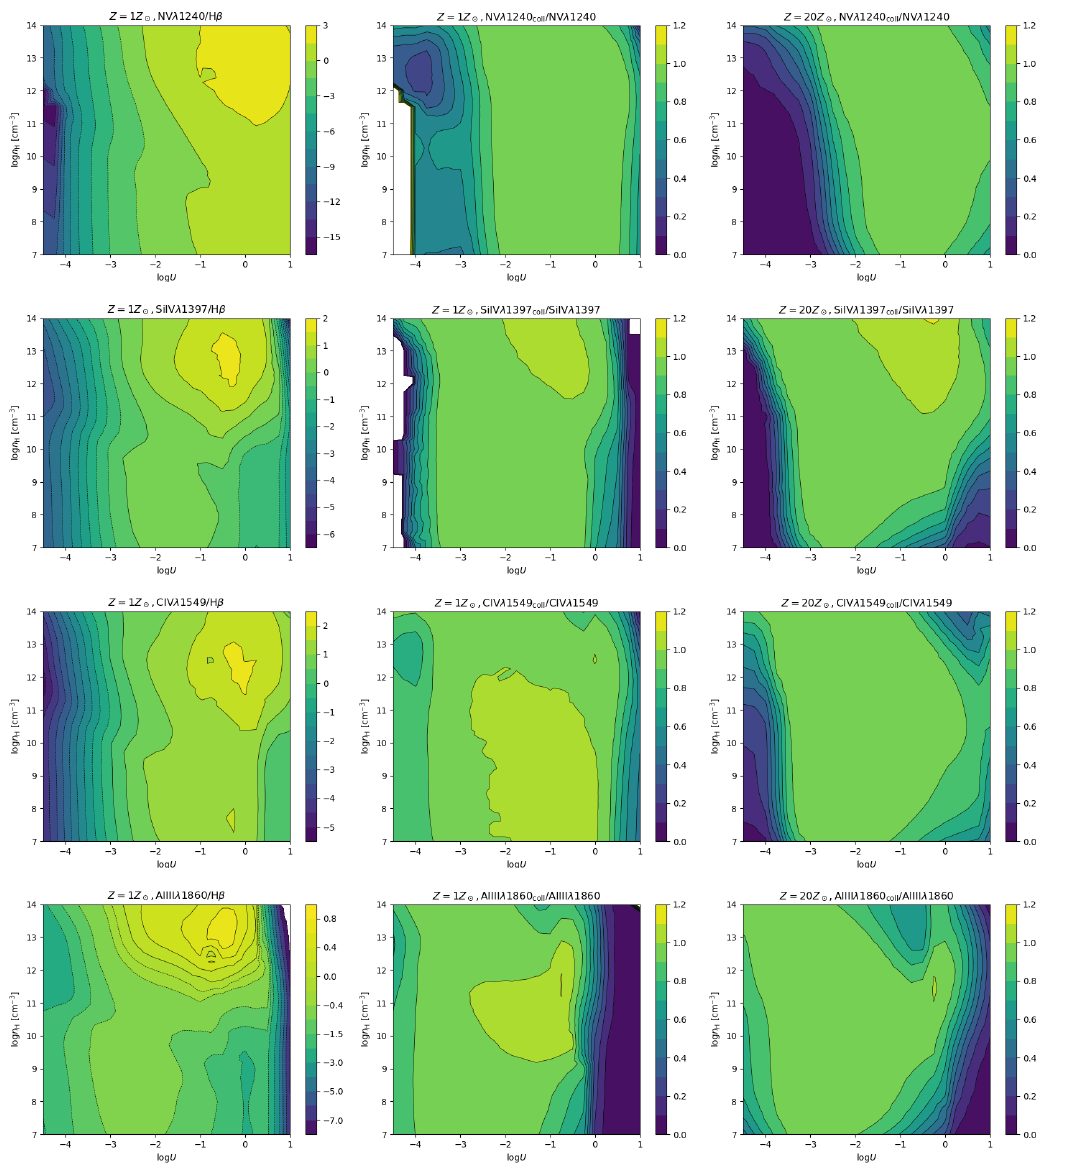
Figure 1. Leftmost panels: the decimal logarithm of the ratio between resonance emission lines and H β as a function of ionization parameter U and hydrogen density n H , from arrays of 667 simulations from CLOUDY 17.02. From top to bottom: N V , Si IV , C IV , Al III . Middle and right panels: the ratio of collisional excitation emission to the total line emission, again as a function of ionization parameter U and hydrogen density n H . Middle: Z = 1 Z (cid:12) ; right: Z = 20 Z (cid:12)